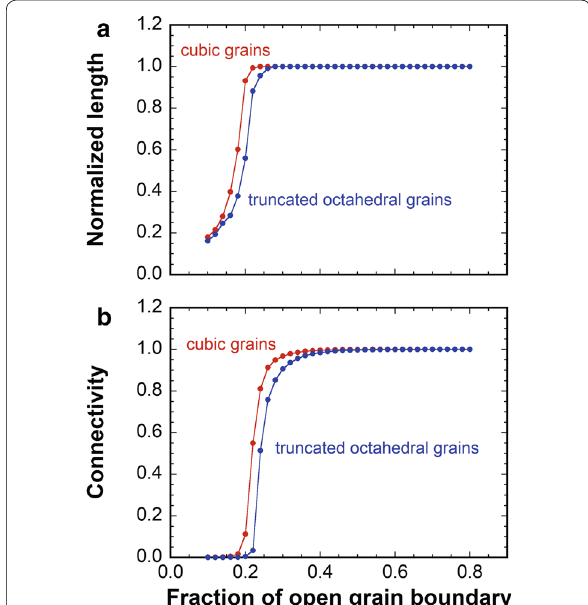
Fig. 10 Normalized length of the largest cluster and connectivity for arrays of cubic and truncated-octahedral grains. a Normalized length of the largest cluster as a function of the fraction of open grain boundary. The length is normalized by the dimension of the array (50) and averaged for 10 numerical experiments. b Connectivity as a function of the fraction of open grain boundary. The connectivity is defined by the ratio of the largest cluster size to the total number of open grain boundaries. The size of a cluster is the number of open grain boundaries in a cluster. The connectivity is also averaged for 10 numerical